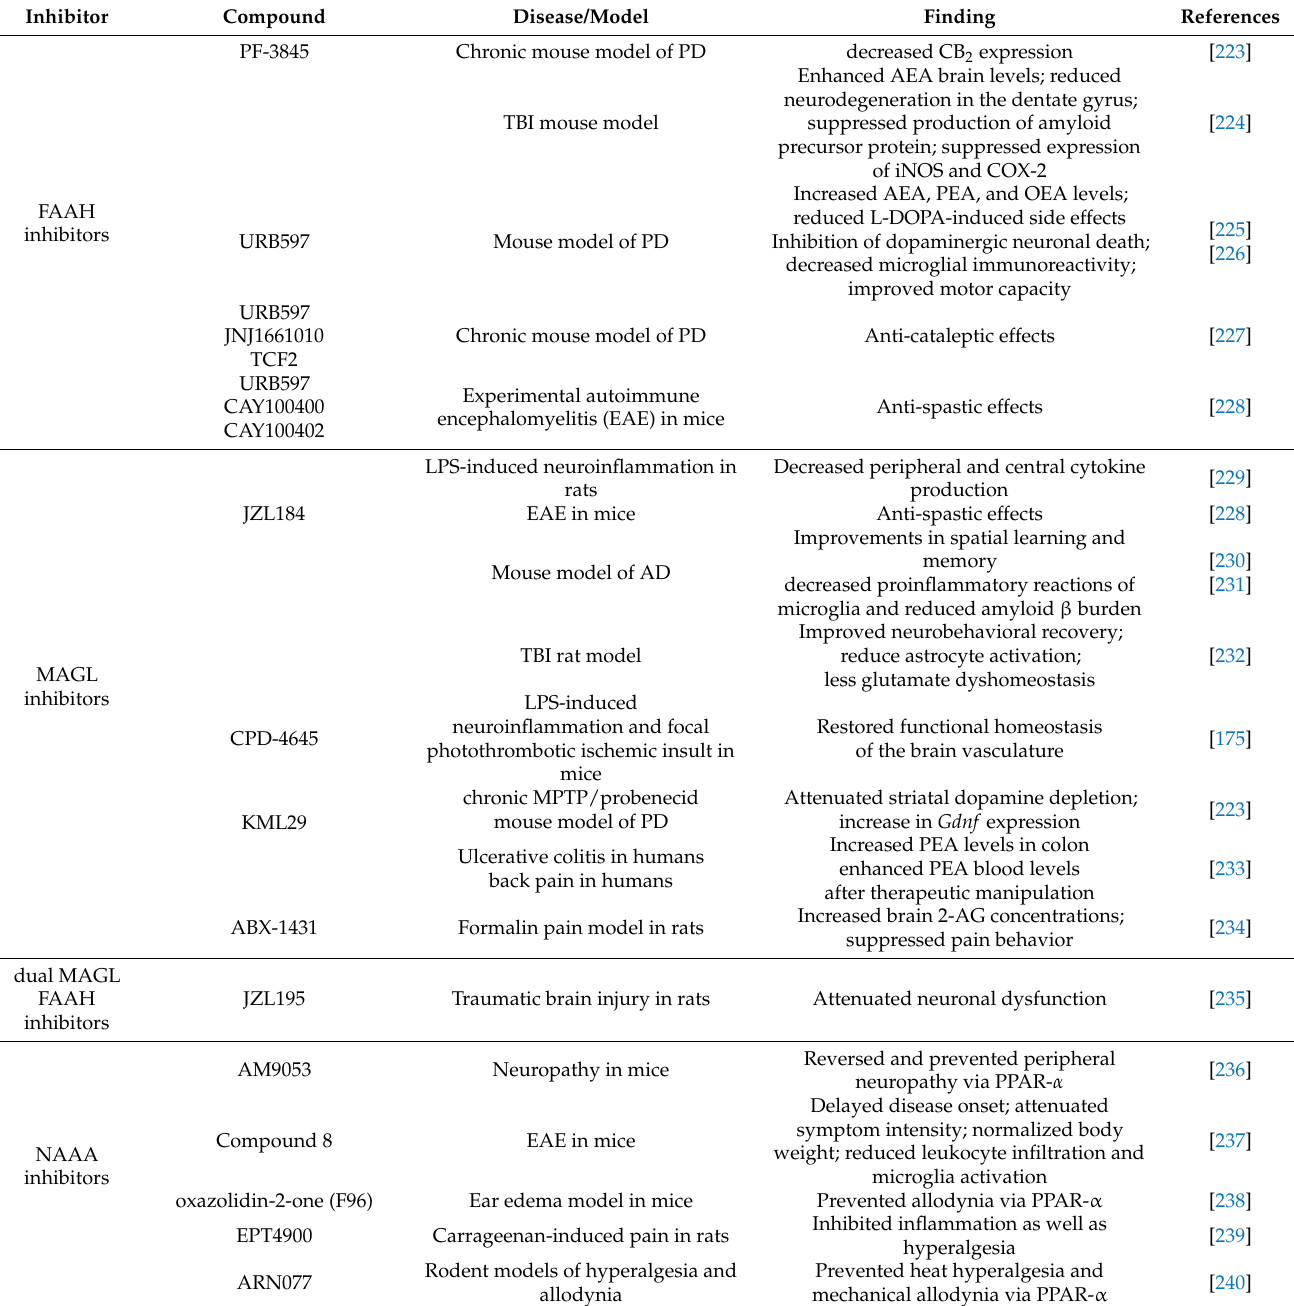
Table 3. FAAH, MAGL, and NAAA inhibitors and their effects in neuroinflammation and neurodegenerative diseases.